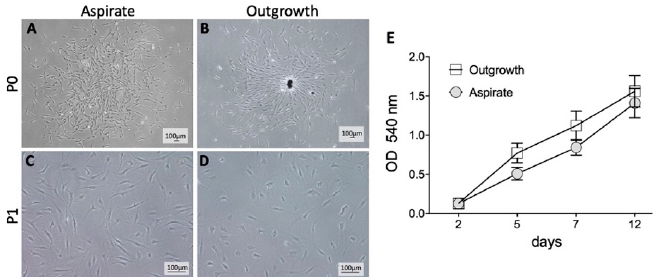
Figure 1. Morphology and proliferation behavior of mesenchymal stromal cells (MSC) from aspirate or outgrowth cultures. ( A , B ) The typical morphology of unpassaged MSCs is depicted. Adhered aspirate cells formed cell clones in contrast to an outgrowth culture with spare bone fragments as a source of cell growth. ( C , D ) All passaged cells appeared to be plastic adhered and spindle shaped. No relevant di ff erences were observed. ( E ) Proliferation rate was measured by using an MTT Assay. Shown data were evaluated by optical density (OD) measurements. All isolated cells were viable and able to proliferate. No significant di ff erences between both niches were detected.